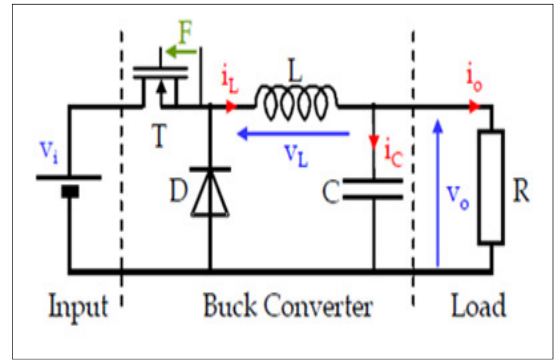
Fig. 8. Buck converter circuit